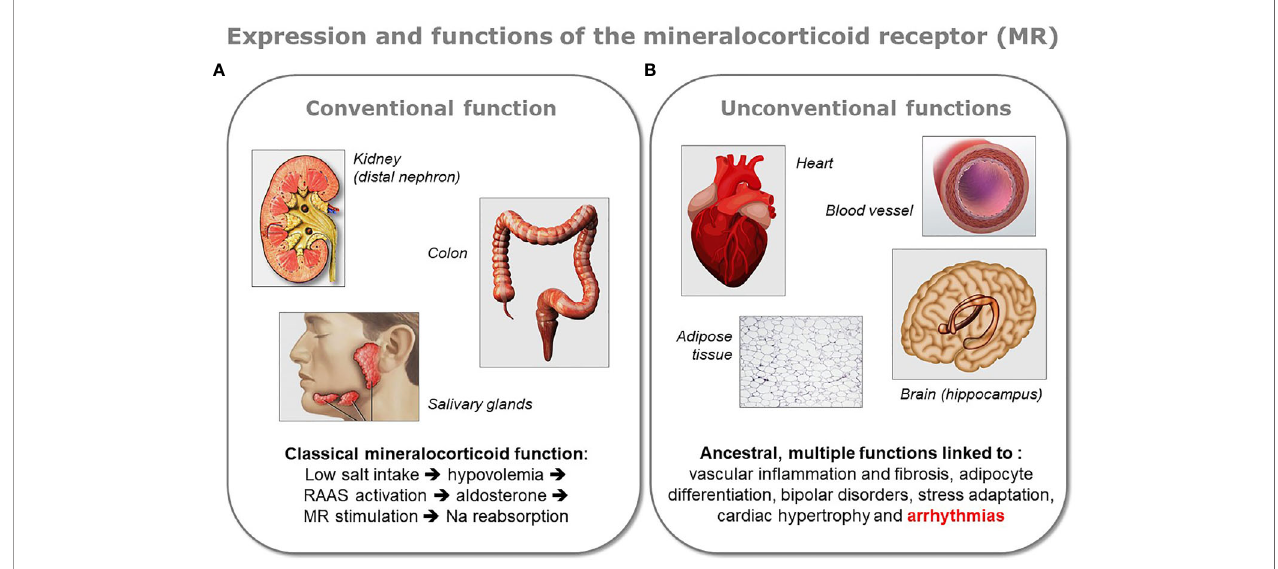
FIGURE 1 | Conventional and unconventional MR functions. The various functions of the mineralocorticoid receptor (MR) can be divided in two groups depending on the organ expressing the protein. (A) The receptor exerts its classical mineralocorticoid function in tight epithelia present in the distal nephron of the kidney, in colon, or in salivary gland, where it facilitates sodium reabsorption upon activation of the renin-angiotensin-aldosterone system (RAAS). (B) MR is also expressed in other organs like the brain (mostly in the hippocampus), the heart, the blood vessels, or the adipose tissue. In the latter organs the role of MR is multiple and less well characterized, however a dysregulation of the receptor has been shown to be linked to several pathologies. Because the presence of MR in these organs appeared in the evolution before the classical mineralocorticoid function associated to aldosterone, these unconventional functions of MR are considered as